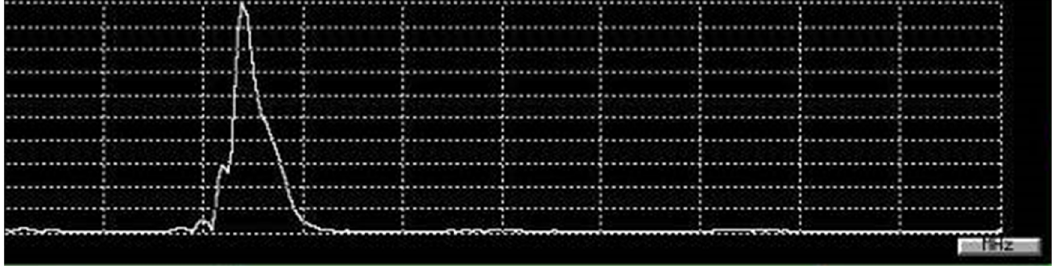
Figure 4: View of the Fourier transform obtained from the pulse of a wave propagating along the boundary of the coating – substrate